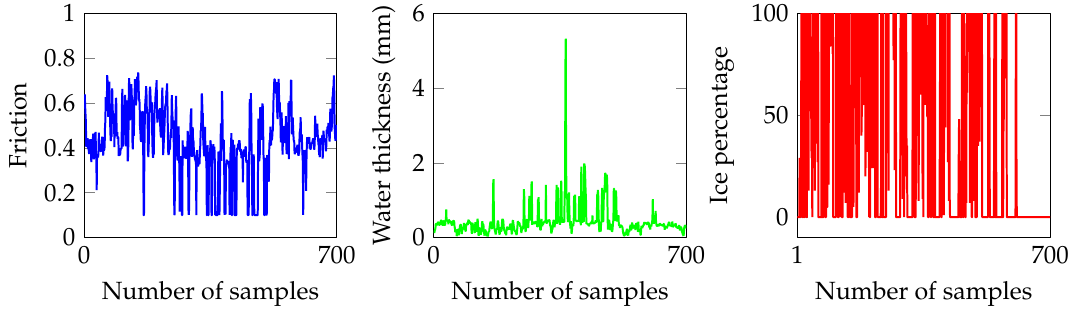
Figure 6. Three of the possible data types that can be extracted from the MARWIS: ( left ) friction; ( middle ) water thickness; and ( right ) ice